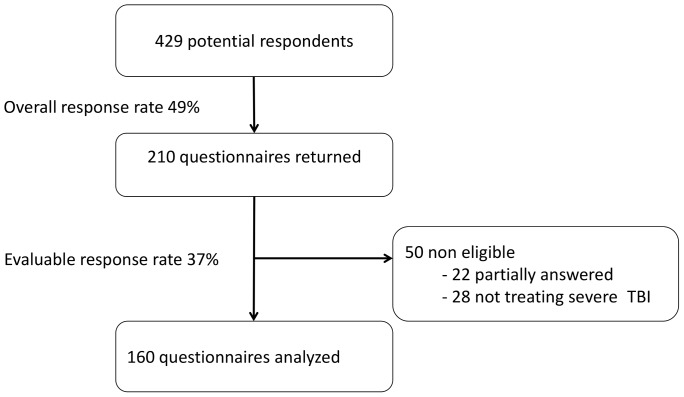
Flow diagram of participants.